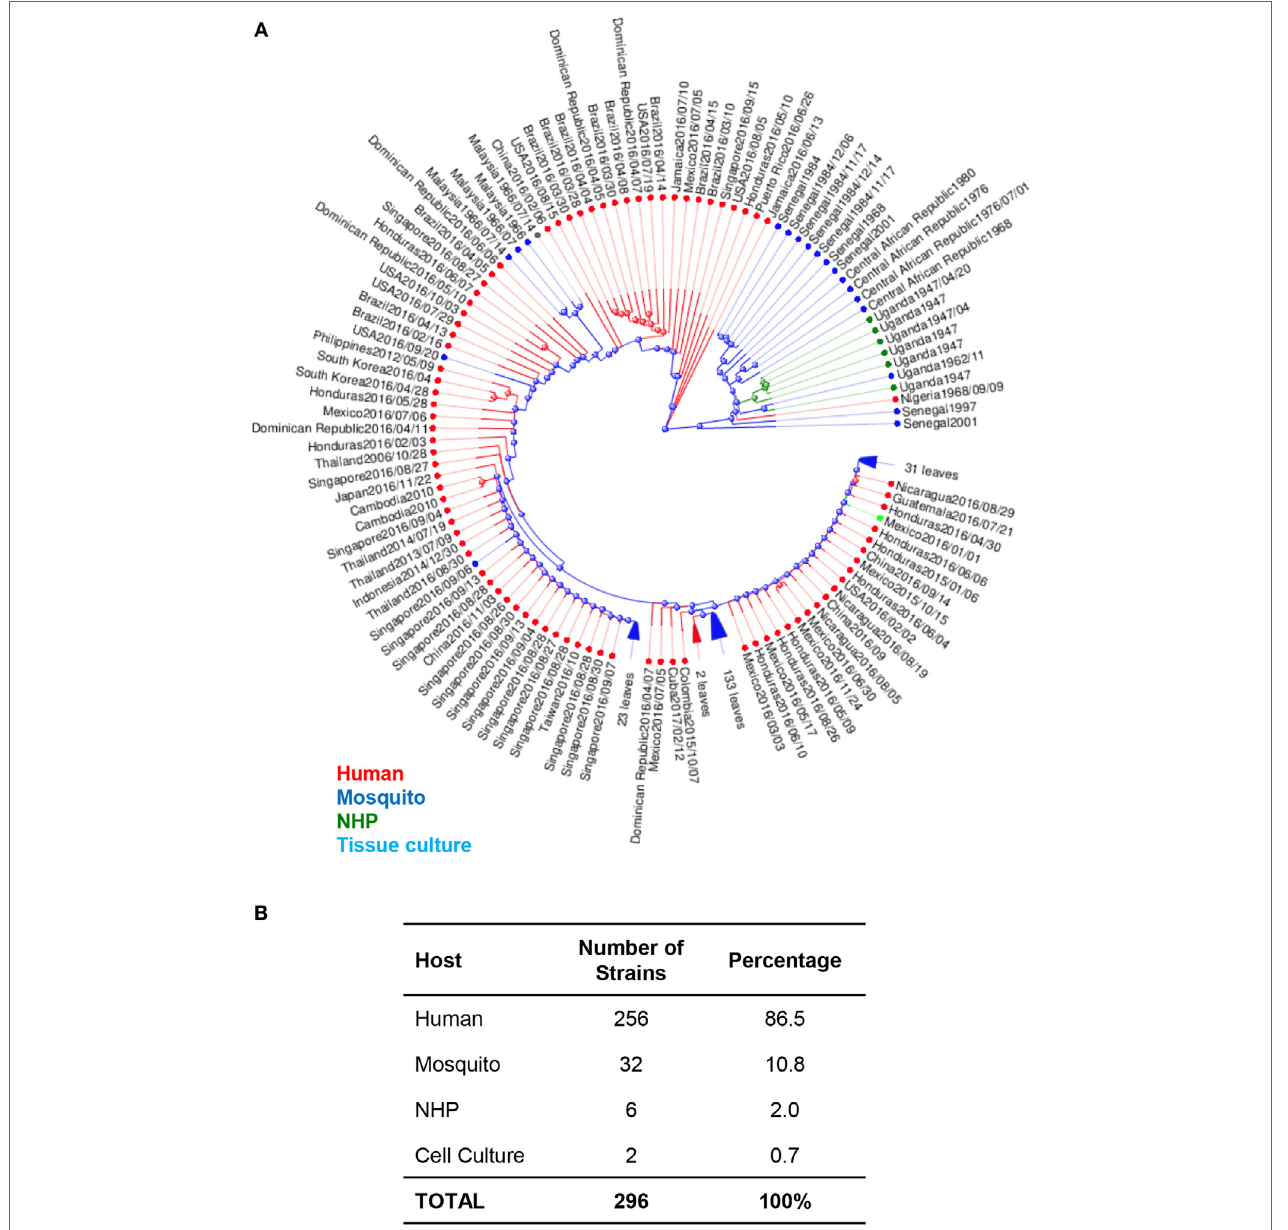
FiGURe 1 | Phylogenetic analysis of Zika virus (ZIKV) genomes by host. (A) Phylogenetic analysis of 296 available ZIKV genomes was organized according to the host species of isolation using Virus Variation analysis system available through NCBI. Only complete nucleotide genomes were screened and duplicate strains were removed to produce 296 unique strains. Strains isolated from humans, mosquitos, NHPs, and cell cultures are labeled with red (humans), blue (mosquitos), green (NHP), and aqua (cell cultures). (B) The total number of strains isolated per host species was used to derive the percentage of each host within the grand